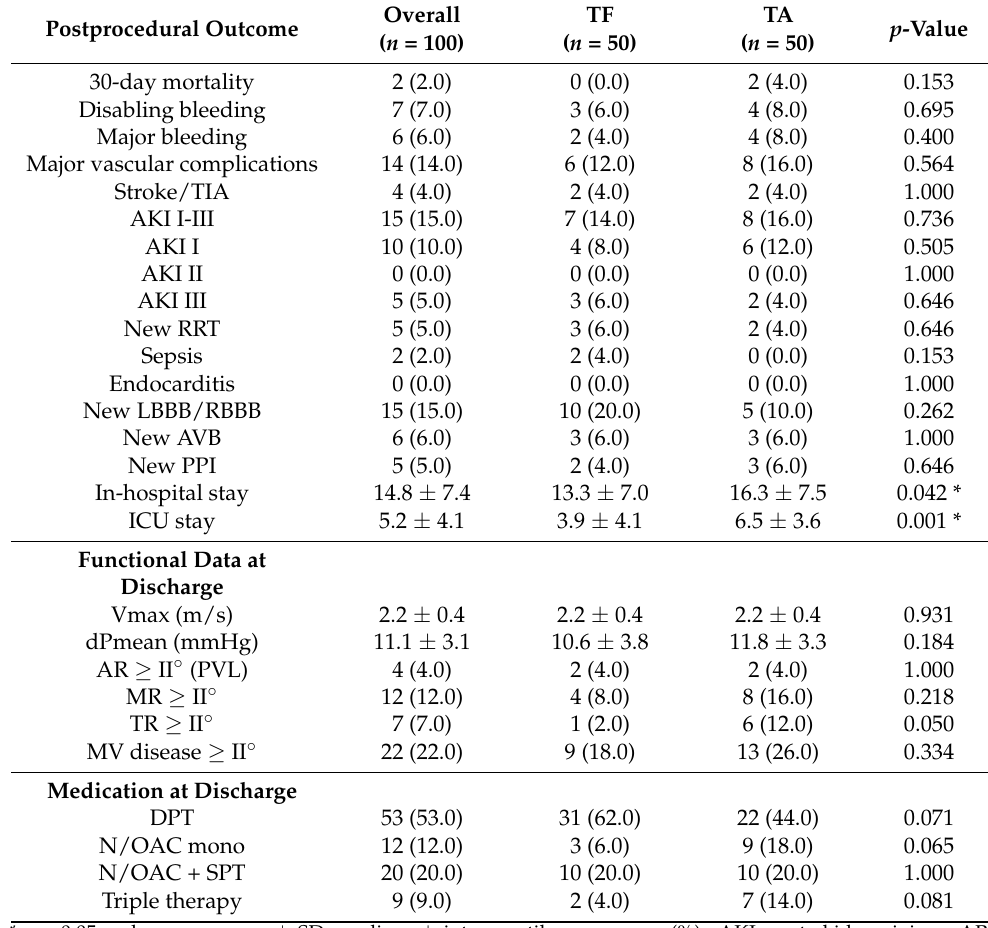
Table 3. Postprocedural